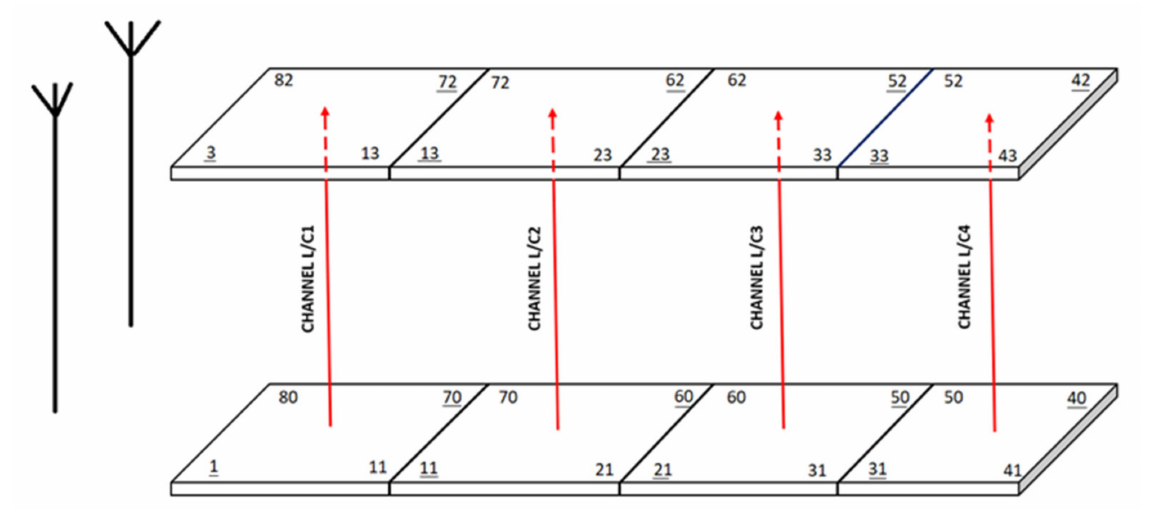
Figure 3. Subject area covered by an AVISOMEF grid on which a Maritime Communication Network on Medium Frequency is established. The channels that are underlined in each cell are listening channels and those that are not underlined are broadcast channels. The connection between AVISOMEF and the Communication Network is established by the different Listening/Calling Channels (channel